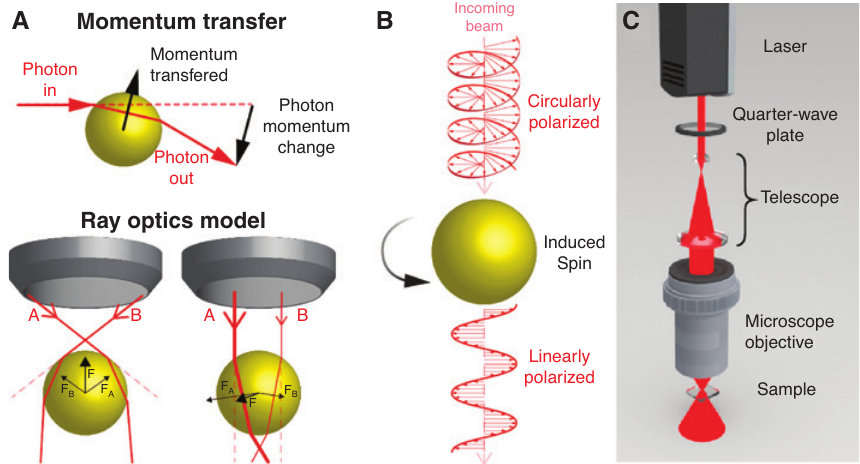
Figure 1: Manipulation of high refractive index transparent particles with light. (A) Top: Sketch illustrating that the refraction of a photon within a particle induces a transfer of momentum to the particle. Bottom: Ray optics model for a focused beam and gradient force. (B) Transfer of angular momentum to a birefringent particle receiving a circularly polarized light and transmitting a linearly polarized light. (C) Basic experimental setup for